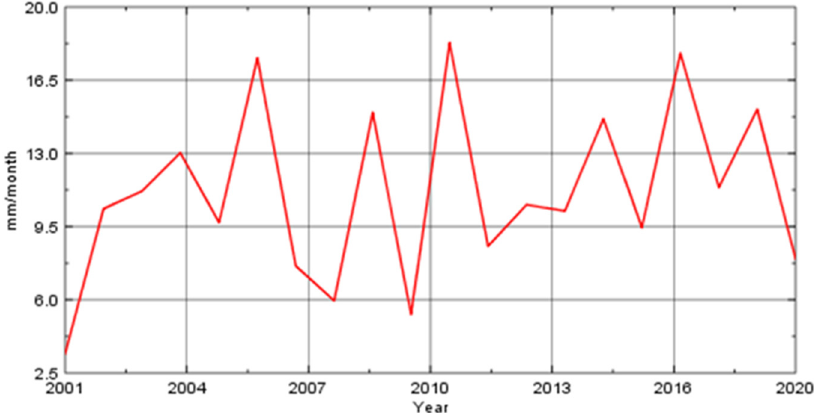
Figure 3. Average monthly satellite-gauge precipitation estimates (2001–2021) over Al Qatif water- shed.